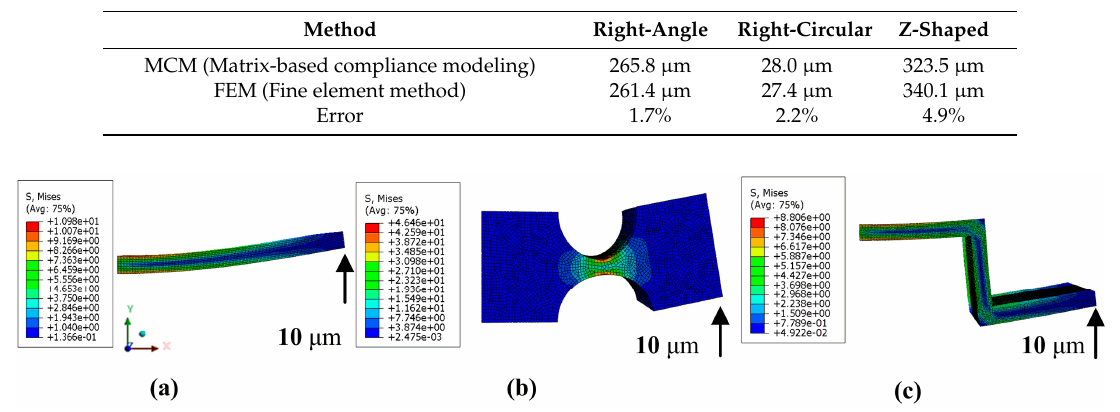
Figure 3. FEM results of different flexure hinges: ( a ) right-angle; ( b ) right-circle; ( c ) “Z-shaped”.